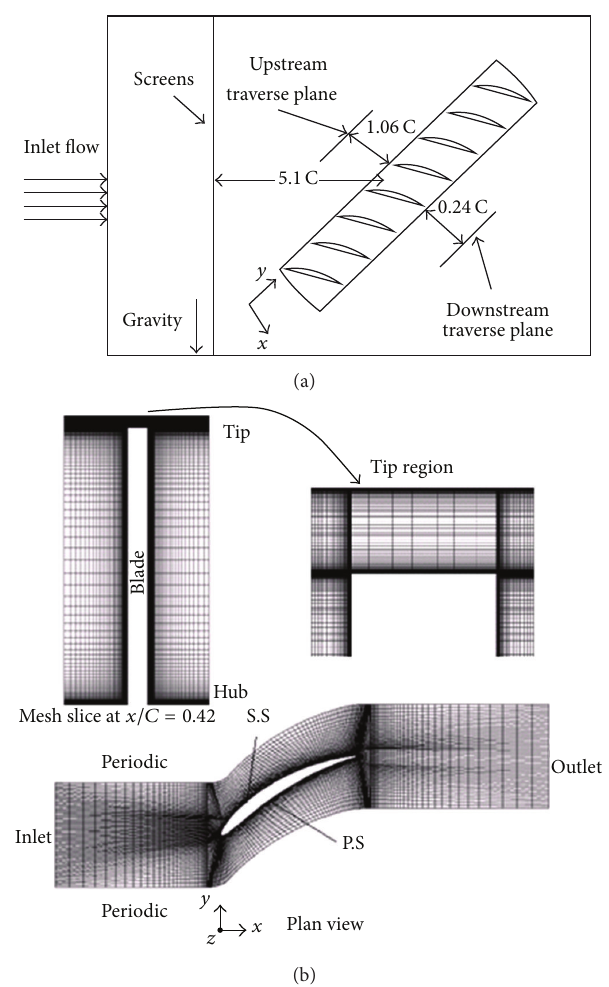
Figure 3: (a) Plan view of the wind tunnel test section with shear generator. (b) Multiblock structured mesh with the “O” grid around the airfoil and triangular prism mesh in the tip region